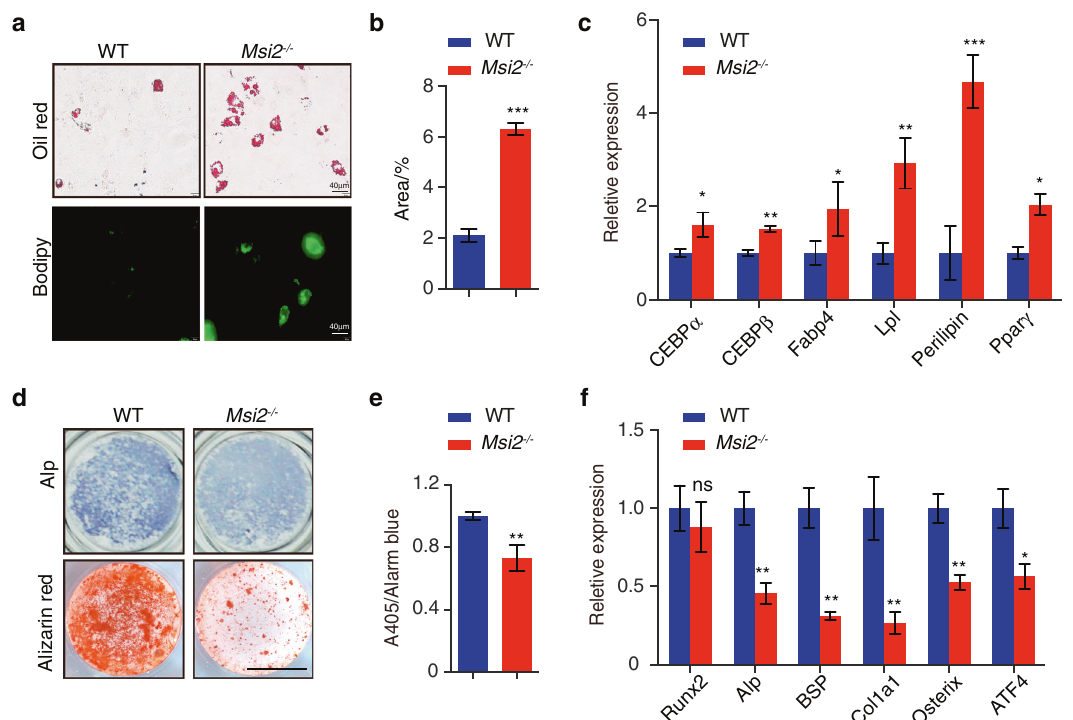
Fig. 4 Msi2 de fi ciency promotes adipogenesis and inhibits osteoblastogenesis in BMSCs. a Oil Red O and BODIPY staining of BMSCs cultured with adipocyte differentiation medium for 6 days. Data are representative of three independent experiments. Scale bar = 40 μ m. b Statistical analysis of the percentage of Oil Red O-positive area via ImageJ. Data are presented as the mean ± SD, n = 4 in each group. Data represent the mean ± SD, *** P < 0.005, unpaired Student ’ s t test. c qPCR analysis of Cebp α , Cebp β , Fabp4 , Lpl, perilipin and Ppar γ expression in BMSCs from the WT and Msi2 − / − mice after adipocyte differentiation for 6 days. Data represent the mean ± SD, n = 4. * P < 0.05, ** P < 0.01, *** P < 0.005, unpaired Student ’ s t test. d ALP staining and Alizarin red S staining after osteoblast differentiation for 7 days (upper) and 14 days (lower). Data are representative of three independent experiments. Scale bar = 3 mm. e ALP activity was measured by phosphatase substrate assays. Data represent the mean ± SD, n = 3. ** P < 0.01, unpaired Student ’ s t test. f qPCR analysis of Runx2 , Alp , Bsp , Col1 α 1 , Osterix , and ATF4 expression after osteoblast differentiation for 7 days; BMSCs were from the WT and Msi2 − / − mice. Data represent the mean ± SD, n = 4. * P < 0.05, ** P < 0.01, ns: no signi fi cance; unpaired Student ’ s t